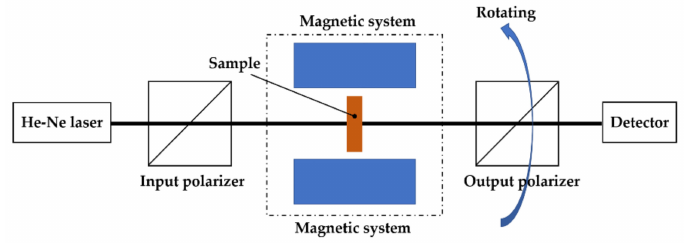
Figure 2. The schematic diagram for measuring the Verdet